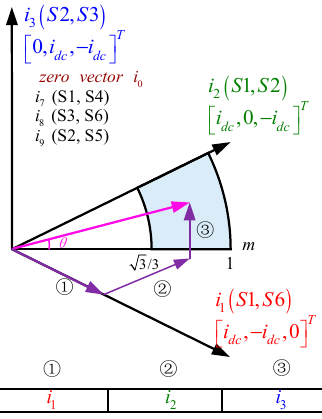
Figure 4. Mechanism for CSC With Non-Nearest Three Vectors modulation scheme in sector 1.